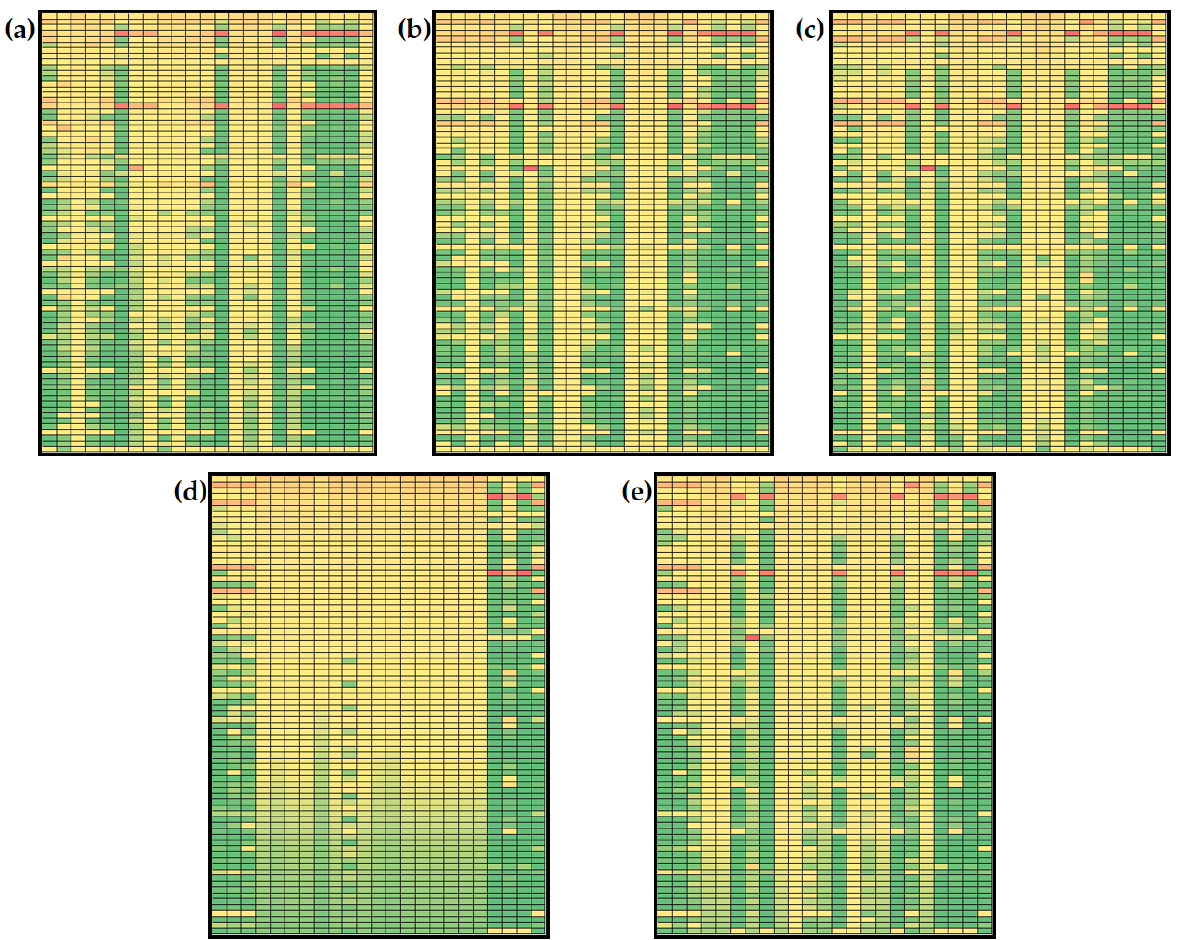
Figure 5. Global sensitivities of hepatic lipid model metabolites (initial conditions for simulations according to Menu 1): ( a ) t f = 10 min, ( b ) t f = 50 min, ( c ) t f = 100 min, ( d ) t f = 250 min, ( e ) t f = 500 min. Rows: β G , β 6 , β f , β l , β m , µ AMP , µ e , µ s , µ 1 , µ 2 , µ 3 , µ 4 , c 0 , c c , d BA , k 10 , k 11 , k 12 , k 13 , k 14 , k 22 , k 5 , k 6 , k 6l , k 6p , k 7 , k 8 , k 9 , k 9a , k a , k aa , k ai , k al , k ba , k bl , k bm , k cl , k cm , k d , k dl , k dy , k ft , k ga , k gi , k gl , k gl2 , k gm , k gm2 , k gp , k lp , k LG , k LH , k MH , k na , k p ,